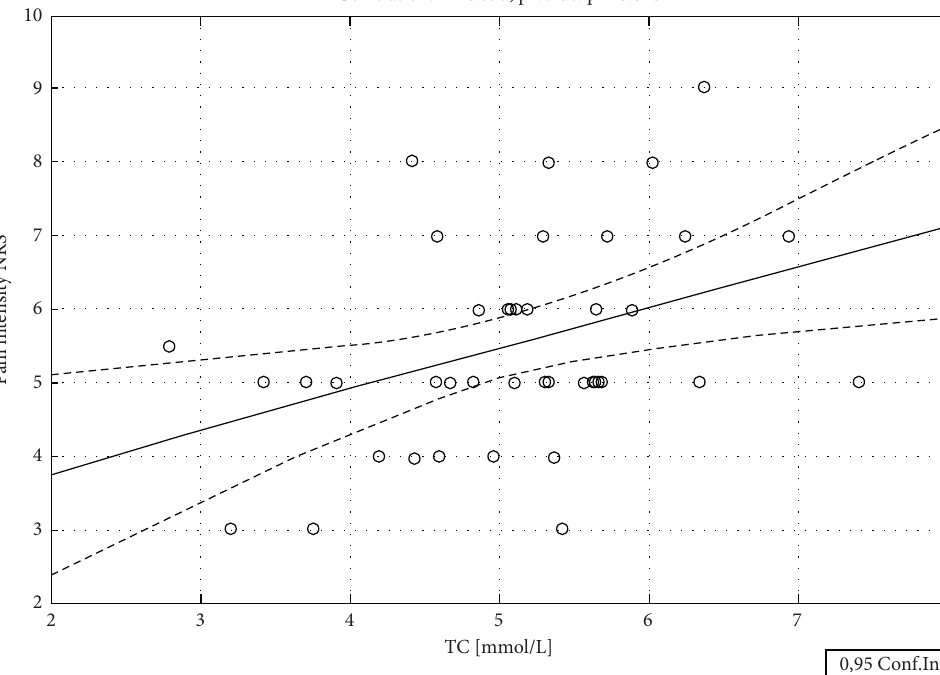
Figure 1: Relationship between pain intensity and total cholesterol levels in patients with whom the treating physician has a positive